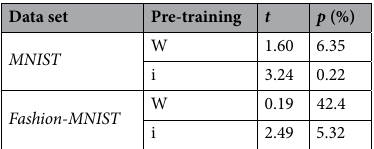
Table 6. Accuracy t-test for improvement through pre-trained information for C. elegans . W—winning ticket, i—structure implantation.